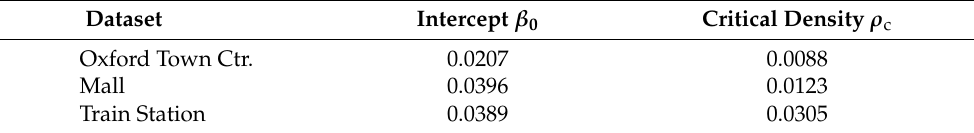
Figure 6. Linear regression (red line) of the social density ρ versus number of social distancing violations v data. Small random noise was added to each data point for better visualization. Green lines indicate the prediction intervals. The critical social densities ρ c are the x-intercepts of the regression lines. Data points might overlap. Table 7. Critical social density